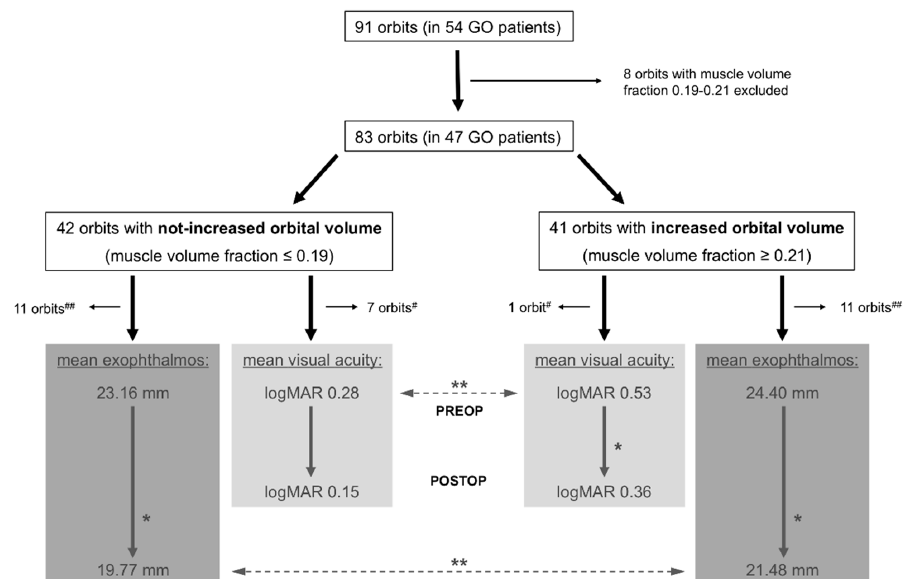
SD, standard deviation; SEM, standard error of mean; CI, confidence interval; DON, dysthyroid optic neuropathy; EUGOGO, European group on Graves’ orbitopathy; CAS, clinical activity score; postoperatively, within the six months after surgery.